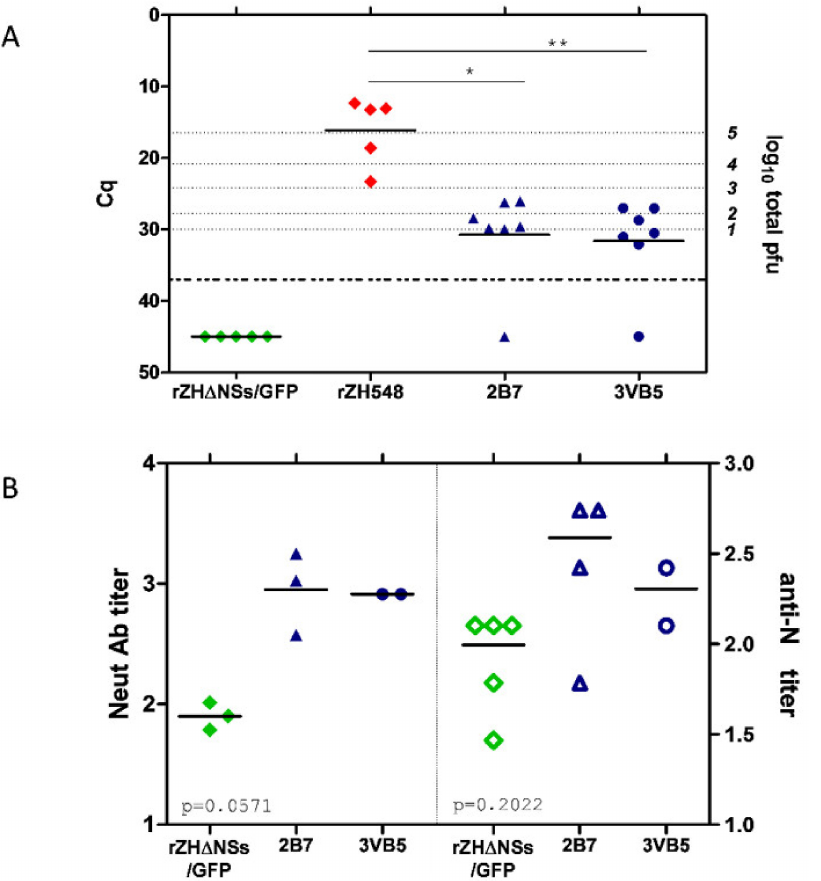
Figure 2. Viremia and seroconversion after inoculation with the rZH548-P82L mutant viruses. ( A ) Viremia. RT-qPCR on EDTA blood samples collected at day 3 pi. Samples giving a Cq (quan- tification cycle) value under the detection level of the assay (37) are arbitrarily represented as 45 and were excluded from the statistical analysis. The correlation of Cq data with pfu equivalents is indicated in the right Y axis. ( B ) Antibody responses in survivor mice at day 18 pi. Titers are expressed as the dilution of serum (log10) rendering a reduction in infectivity of 50% in a microneutralization assay (left Y-axis; closed symbols), and last dilution of serum (log10) giving an OD reading at 450 nm over 1.0 in anti-N ELISA (right Y-axis; open symbols). Each symbol corresponds to an individual mouse. For neutralization, only n = 3 samples were available for rZH548 ∆ NSs::GFP and 2B7. * p ≤ 0.05, ** p ≤